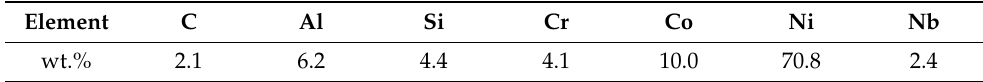
Table 1. Chemical composition of the turbine